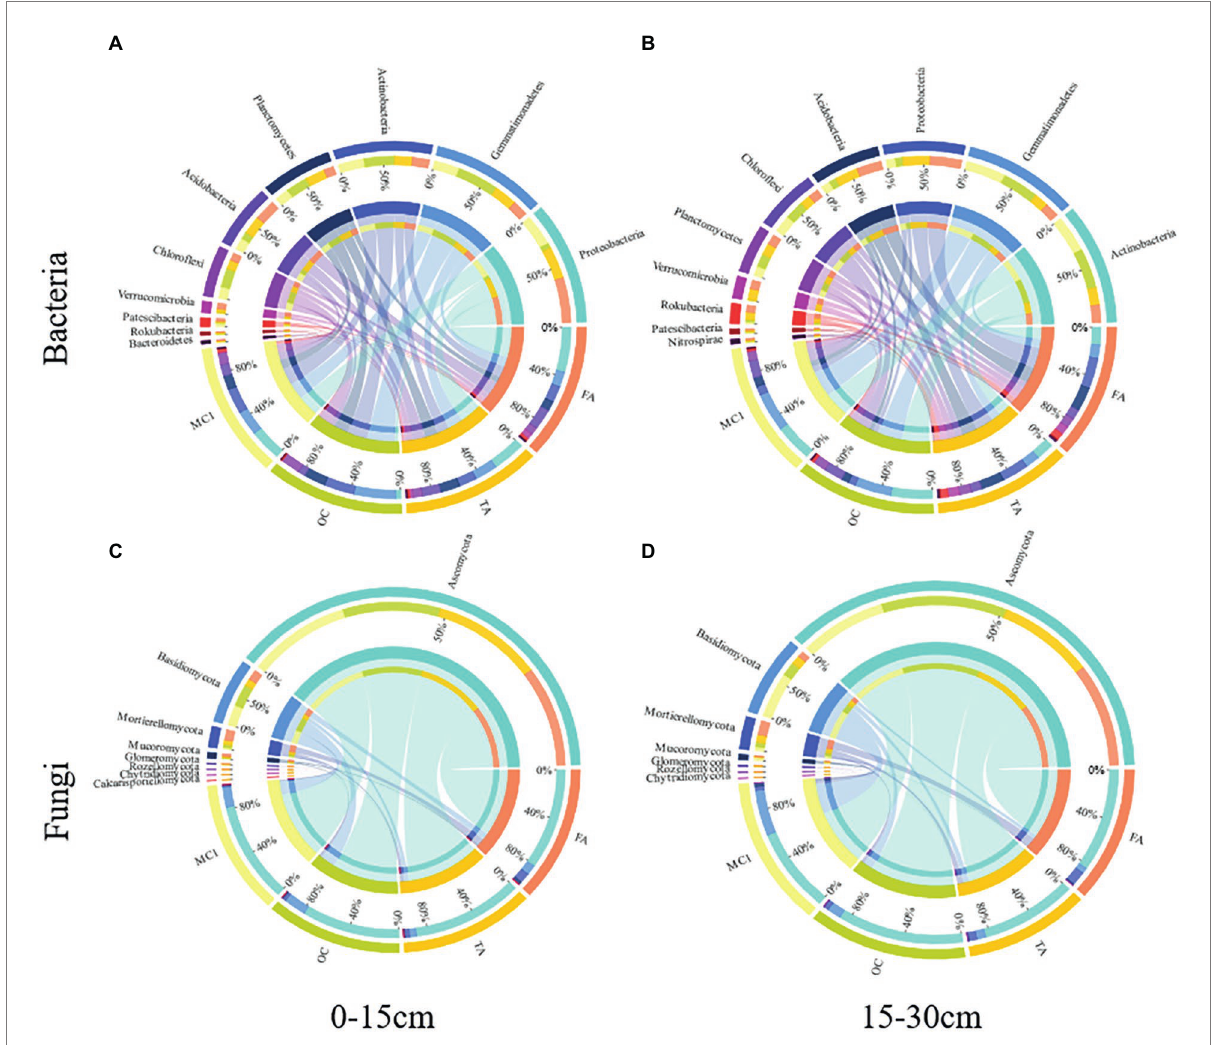
FIGURE 3 Circos plots represent the relative abundance of the top 10 bacterial phyla and the top 8 fungal phyla at different soil depths. The relative abundance of bacteria at the 0-15 cm soil depth (A) and the 15-30 cm soil depth (B) and the relative abundance of fungi at the 0-15 cm soil depth (C) and the 15-30 cm soil depth (D) under different